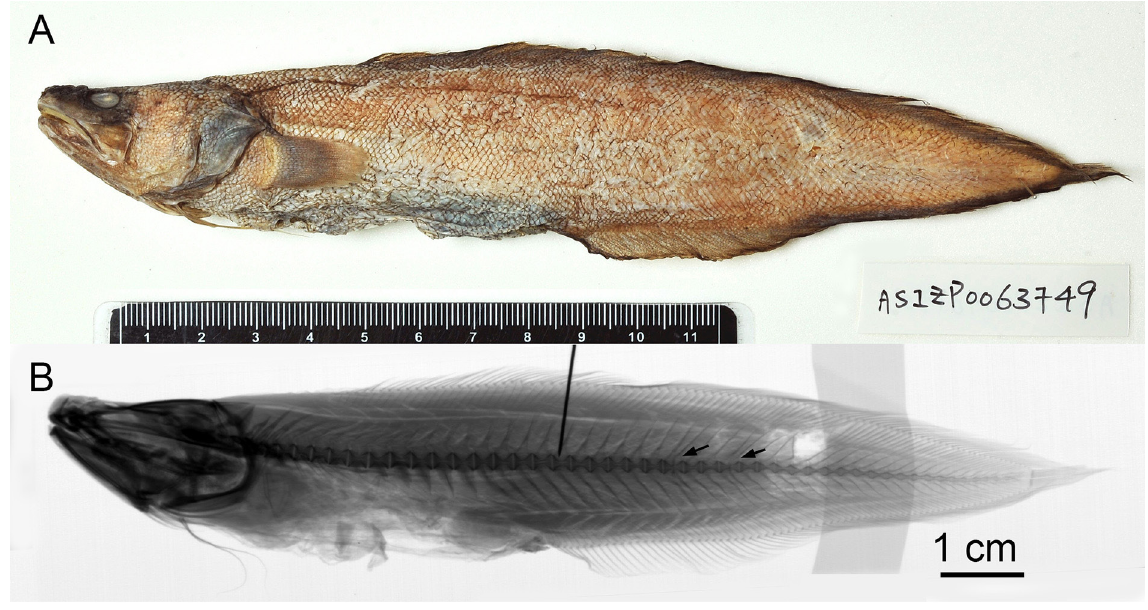
Fig. 7. Luciobrotula bartschi Smith & Radcliffe 1913. Voucher specimen, 181.6 mm SL (ASIZP 0063749). A . Preserved specimen. B . Radiograph. Needle points to the end of the lateral line. Arrows point to